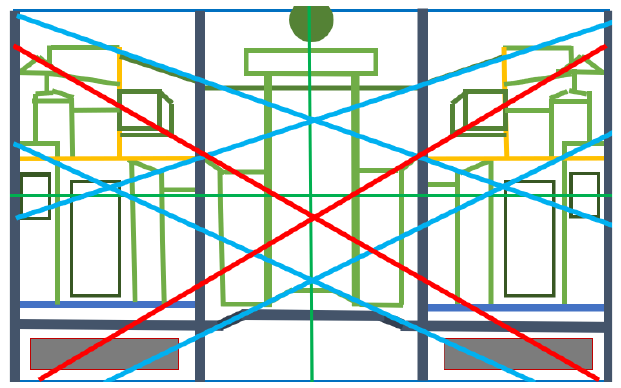
Figure 23. Vanishing vertical axis on facsimile. Source: the author.